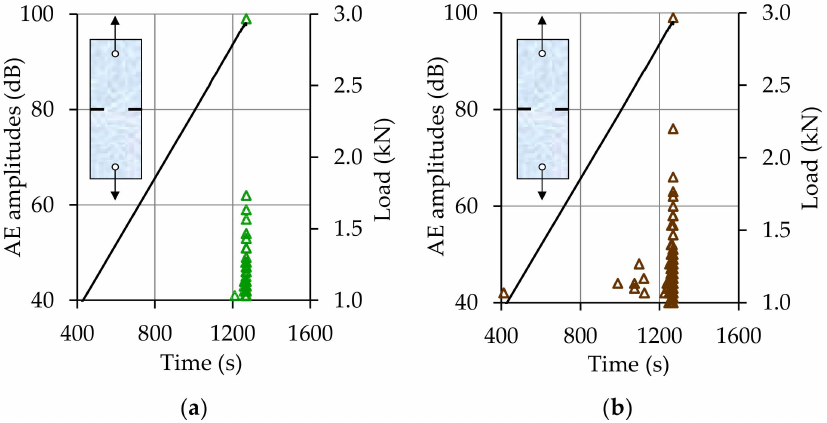
Figure 4. ( a , b ) The temporal evolution of the amplitudes of the acoustic emissions (AEs) recorded by the two acoustic sensors located close to the crowns of the two